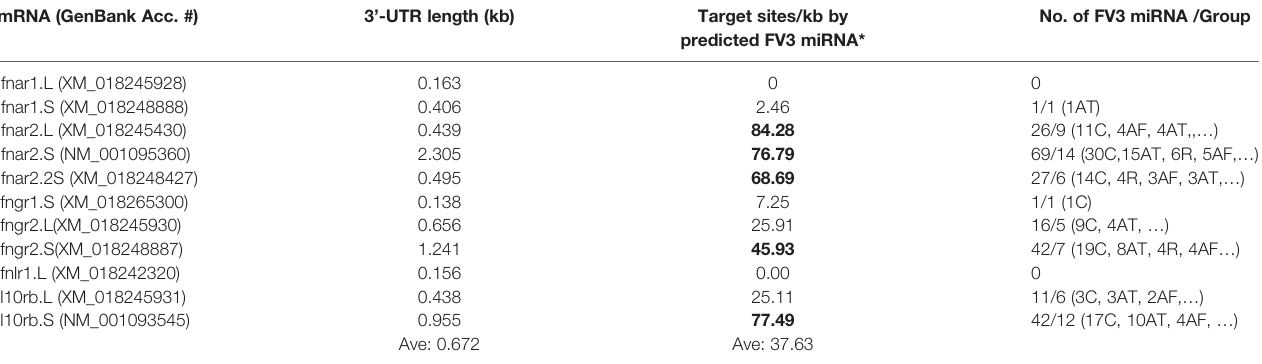
TABLE 1 | Enrichment of predicted FV3 miRNA targeting sites in the mRNA 3-UTR regions of interferon receptors, especially the beta subunits. mRNA (GenBank Acc. #) 3 ’ -UTR length (kb) Target sites/kb by predicted FV3